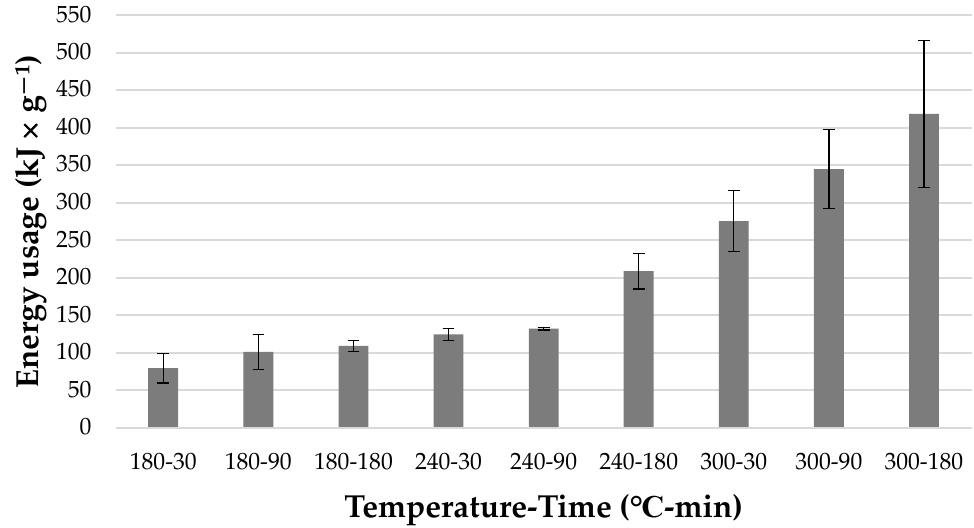
300 ◦ C in 180 min, with a dry basis of the obtained HC .